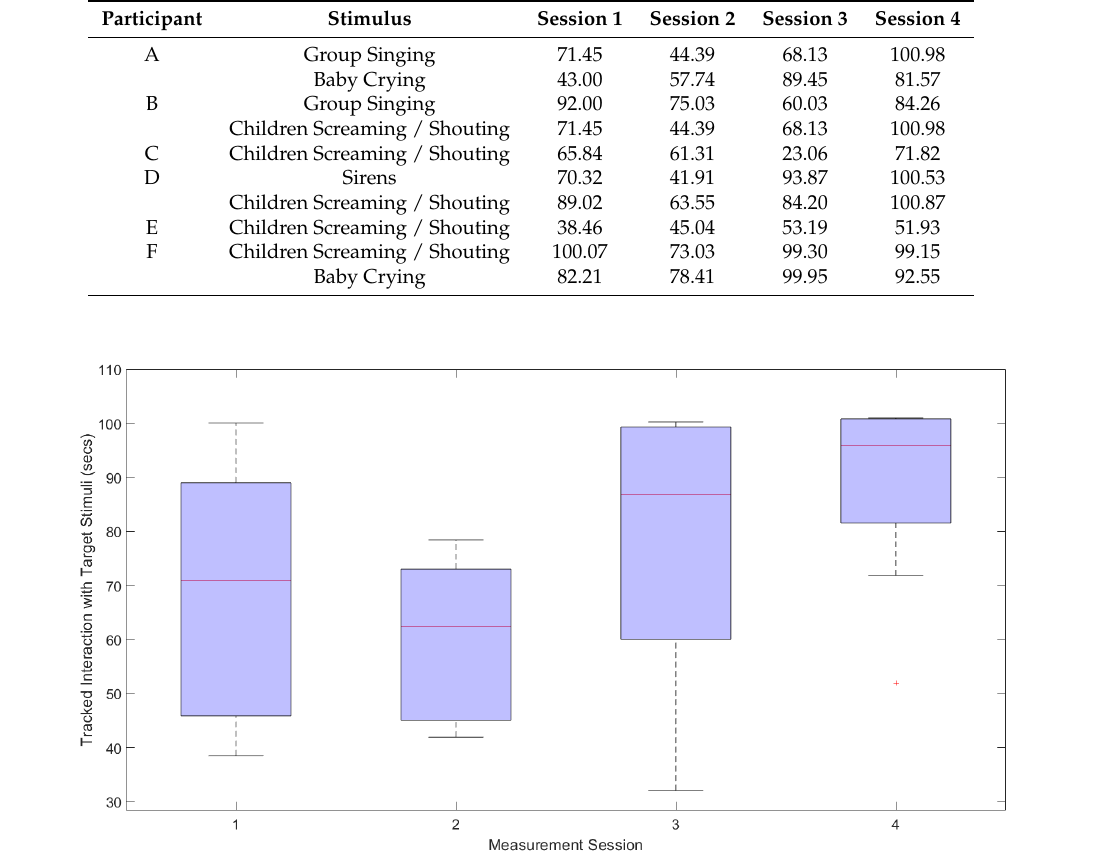
Figure 8. Box plot displaying the tracked interaction time with target stimuli for all participants across each